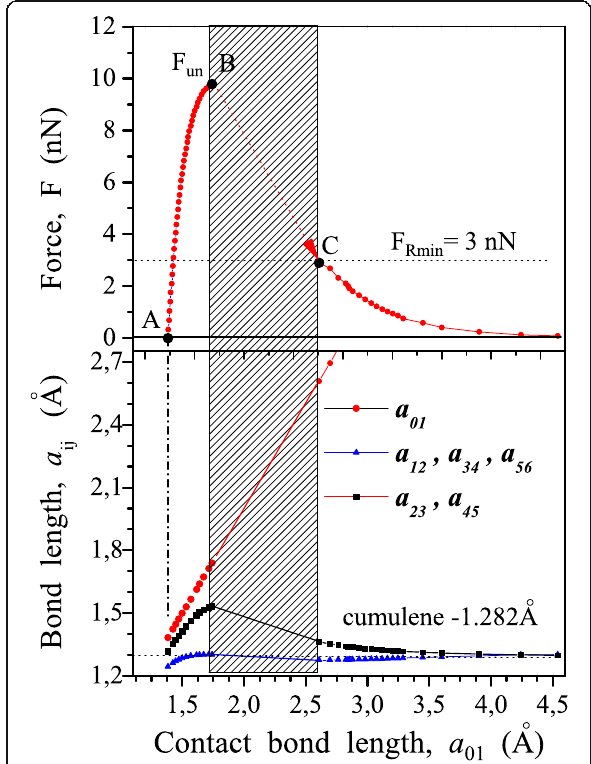
Fig. 4 Dependence of force, F , acting in a contact bond, on its length, a 01 , as well as accompanied changes in the lengths of atomic bonds inside of the carbyne